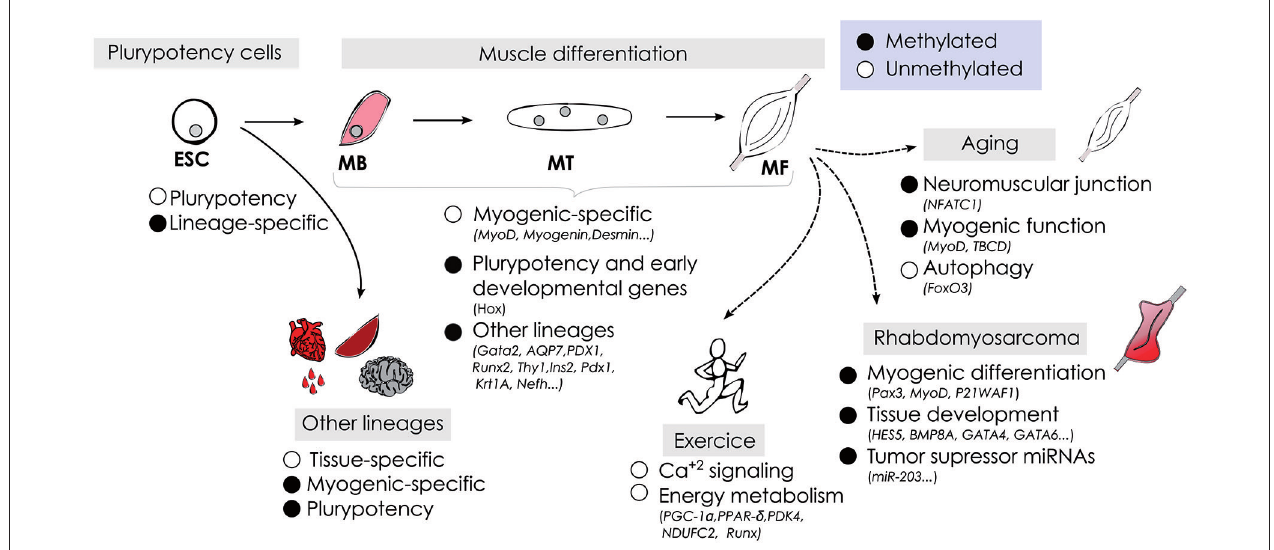
FIGURE 2 | Schematic representation of DNA methylation dynamics during myogenesis under physiological and pathological conditions .